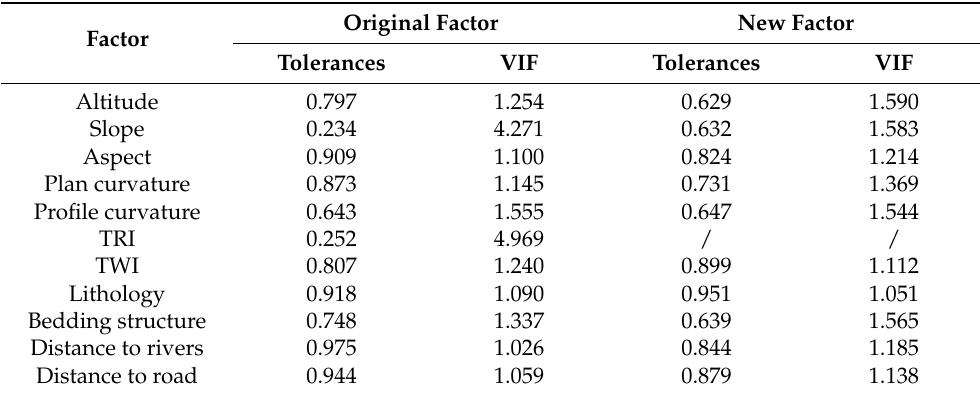
Table 2. Multicollinearity of the causal